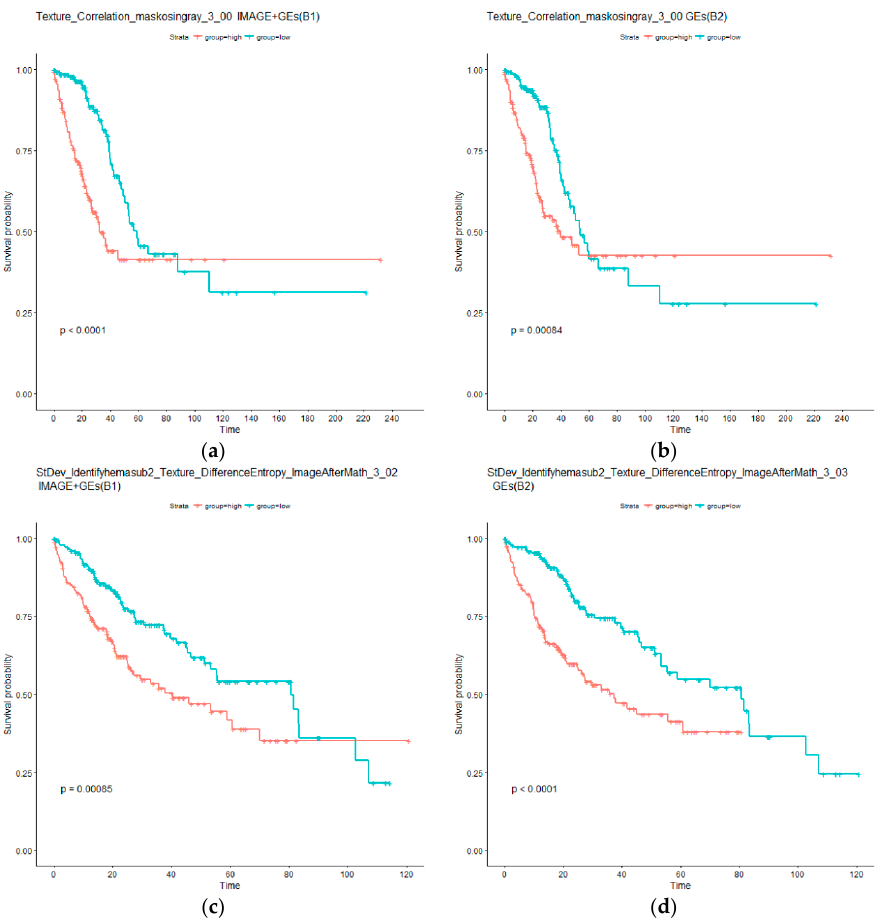
Figure 4. KM curves for low (blue) and high (red) risk groups under models B1 and B2. ( a , b ) for LUAD: Imaging feature Texture_Correlation_maskosingray_3_00 as well as selected gene expressions (B1), and only selected gene expressions (B2). ( c , d ) for LIHC: Imaging feature StDev_Identifyhemasub2_Texture_DifferenceEntropy_ImageAfterMath_3_00 as well as selected gene expressions (B1), and only selected gene expressions (B2). p values are computed from log rank tests.